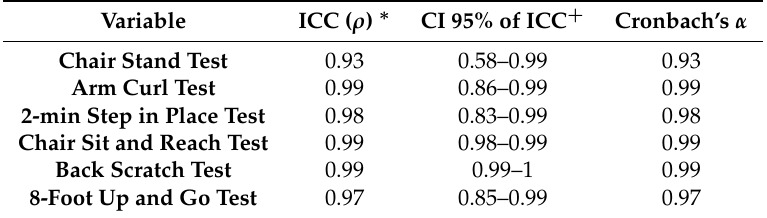
Table 3. Inter-rater reliability between traditional Senior Fitness Test and